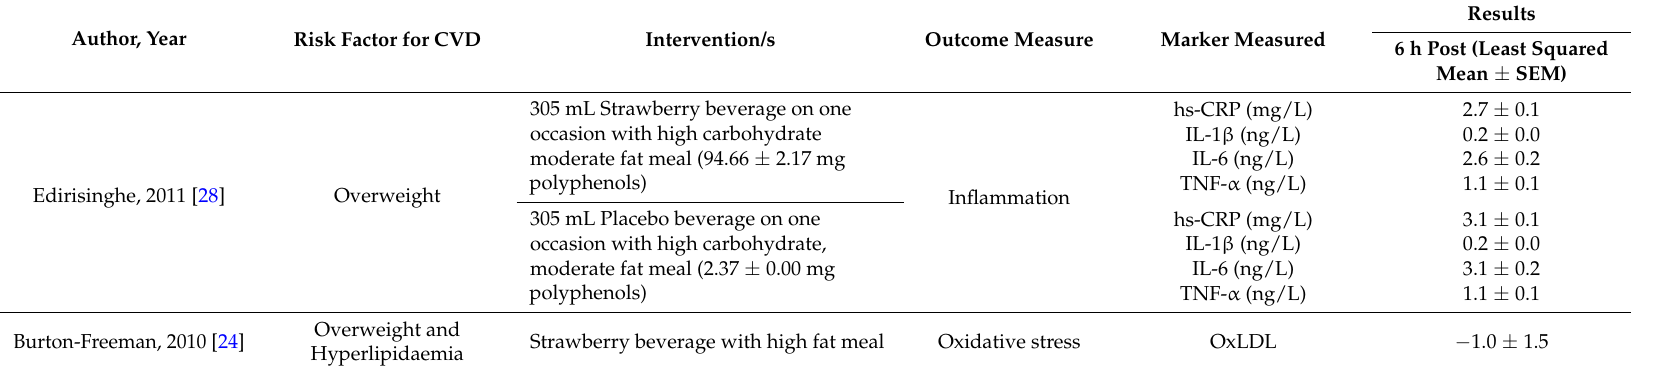
Table 8. Effect of strawberry polyphenols on oxidative stress and inflammation six hours